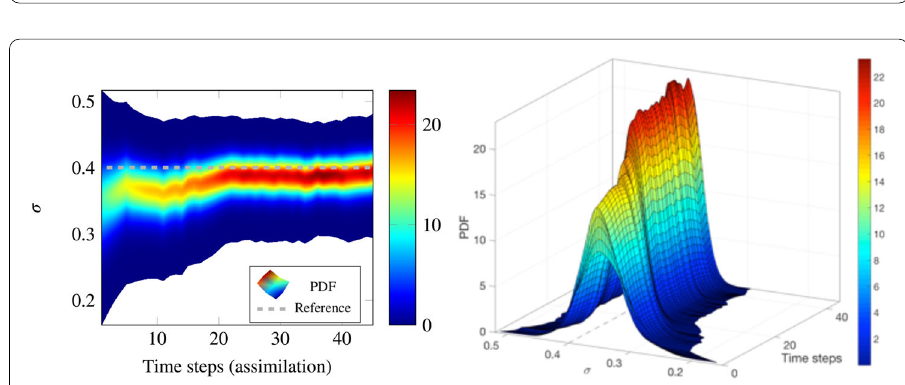
Fig. 10 Cost of the transport maps computations using Hessian information for each assimilation activated - case 1